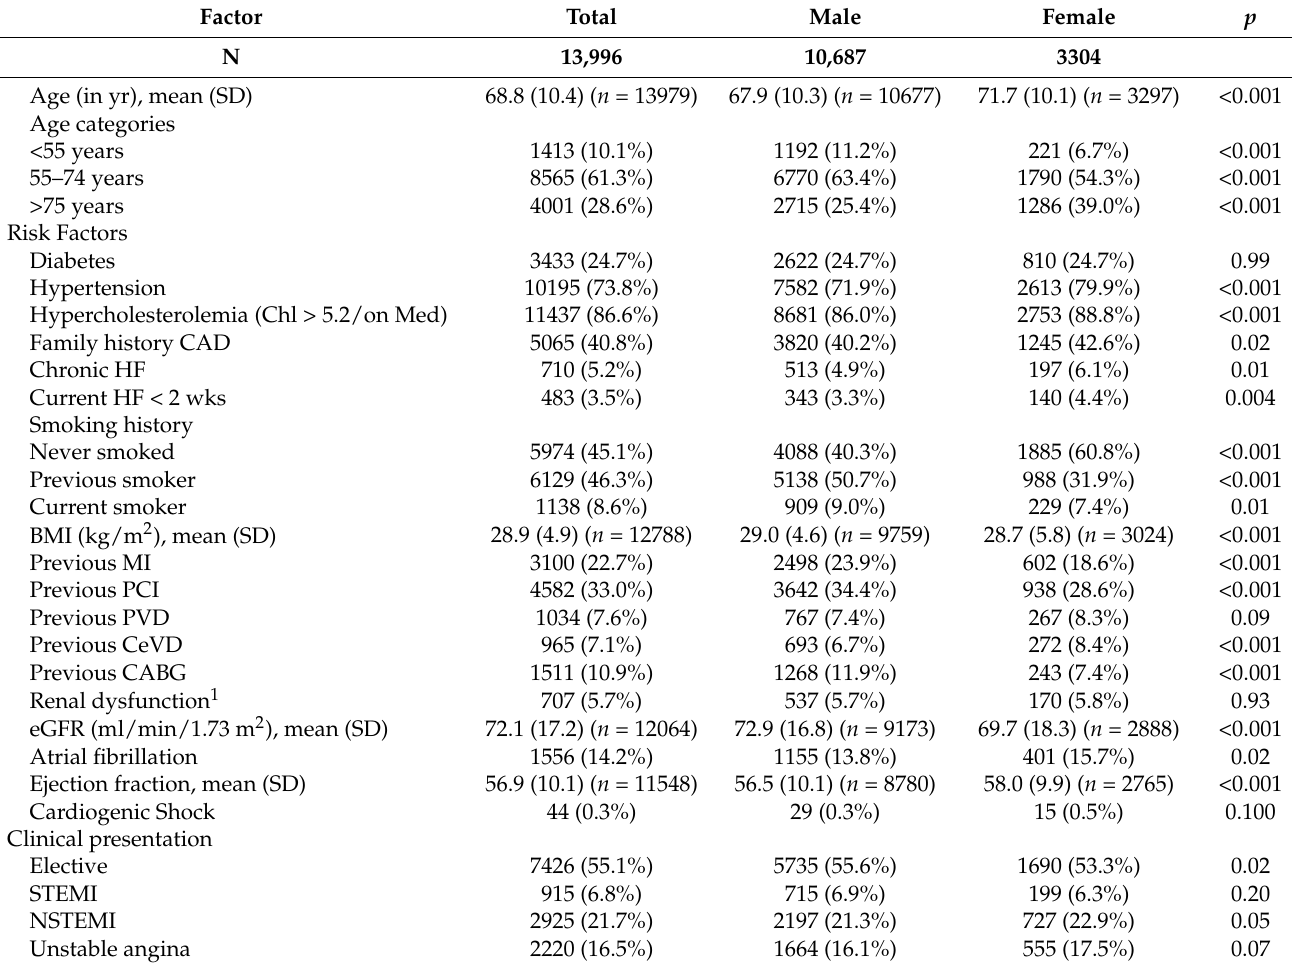
Table 1. Patient